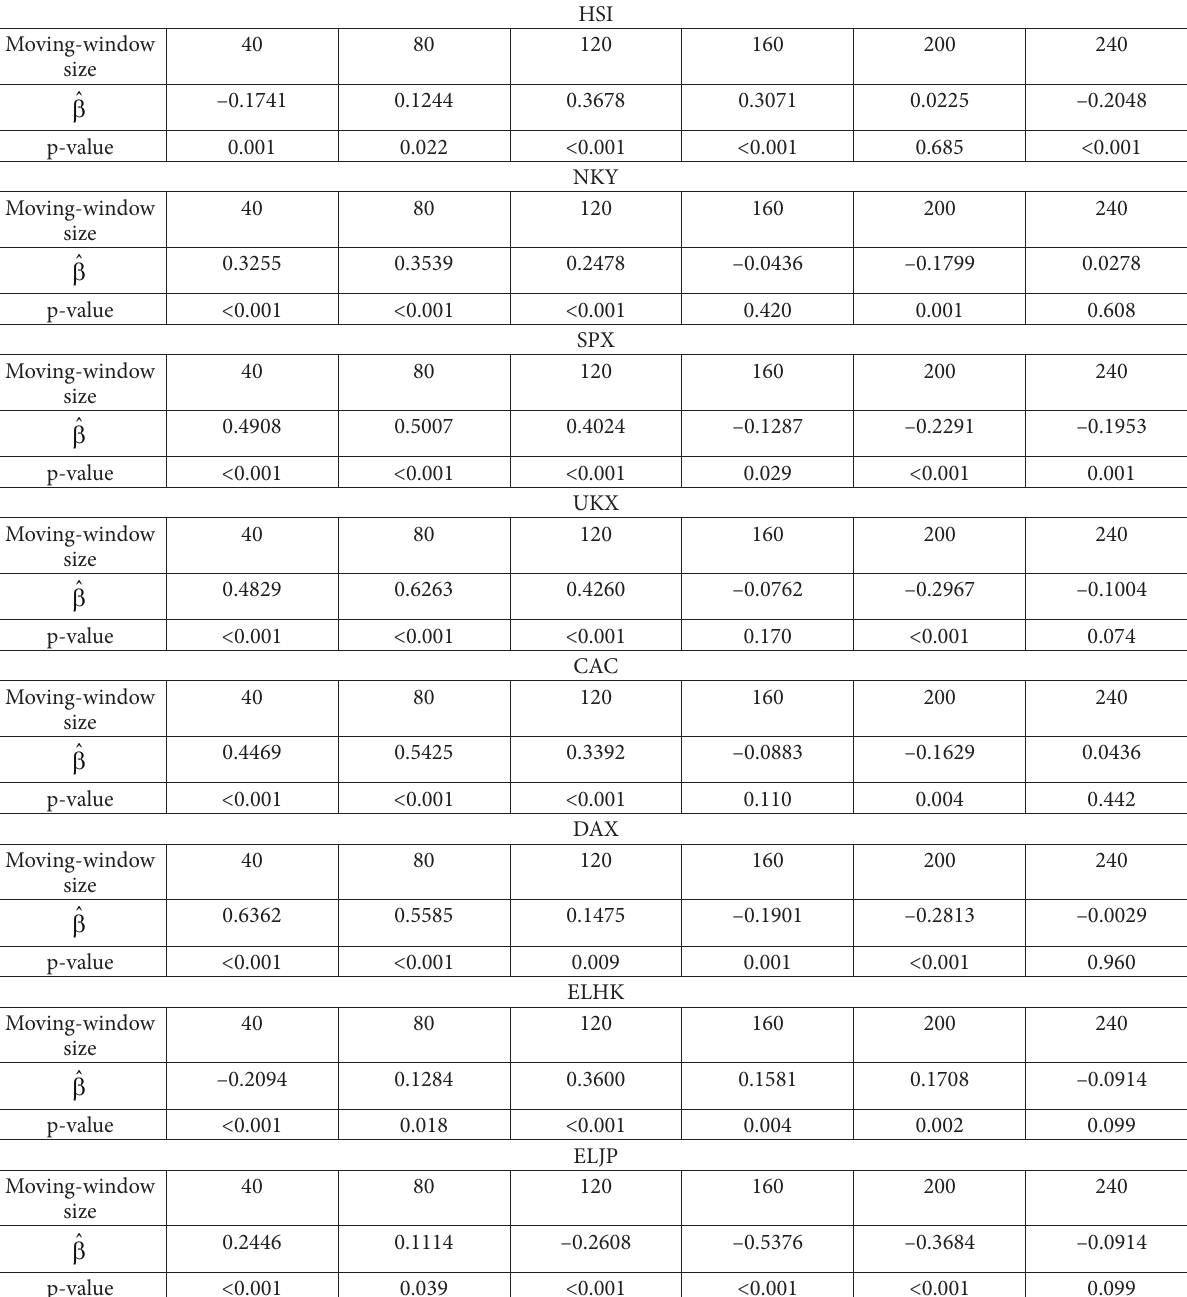
Table 10. The test results for the Halloween effect using Method